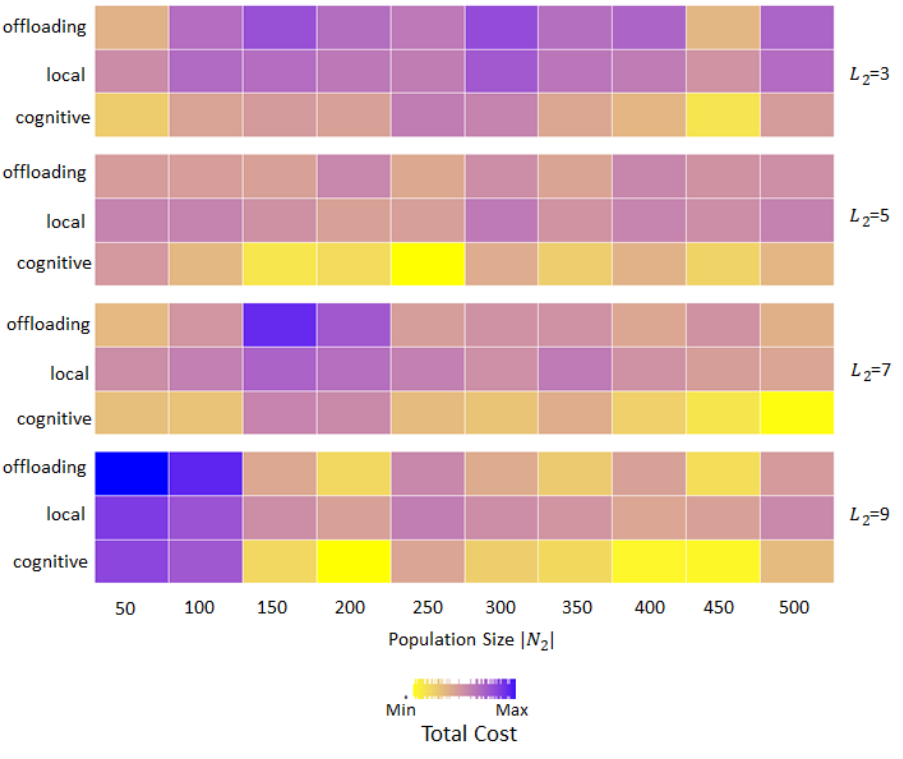
Figure 7. Heatmap of total cost sensitivity. For each computing decision considered (offloading to neighbors, local computation, cognitive computing), the heatmap is displayed considering a population size |N 2 | basis (ranging from 50 to 500) and different numbers of layers ( L 2 = 3, L 2 = 5, L 2 = 7 and L 2 = 9), where colors (ranging from yellow to blue) indicate the total cost